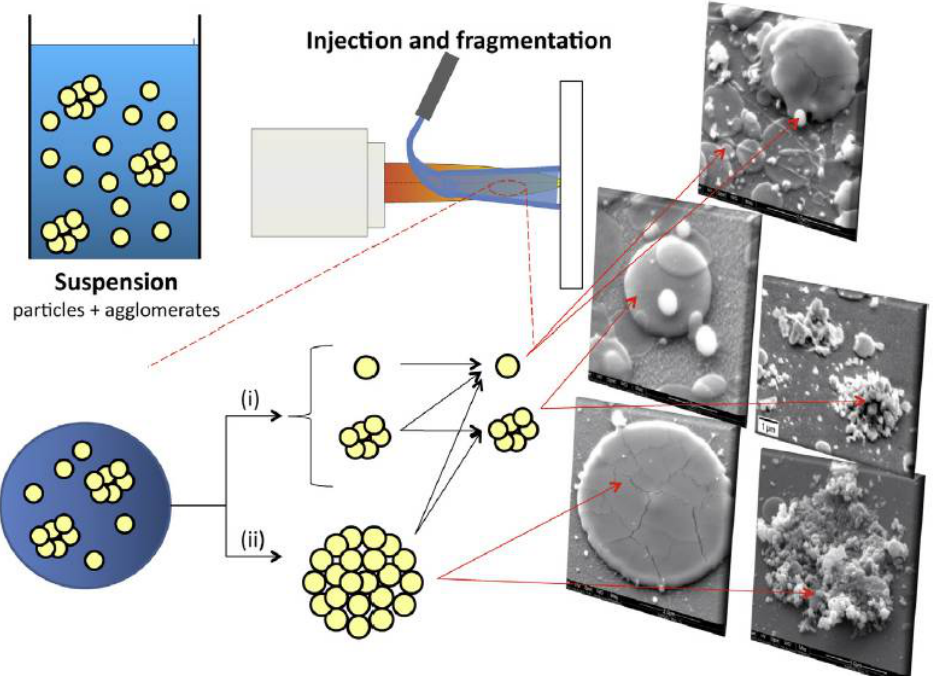
Figure 13. Display to deposits system used in the SPS method [59].